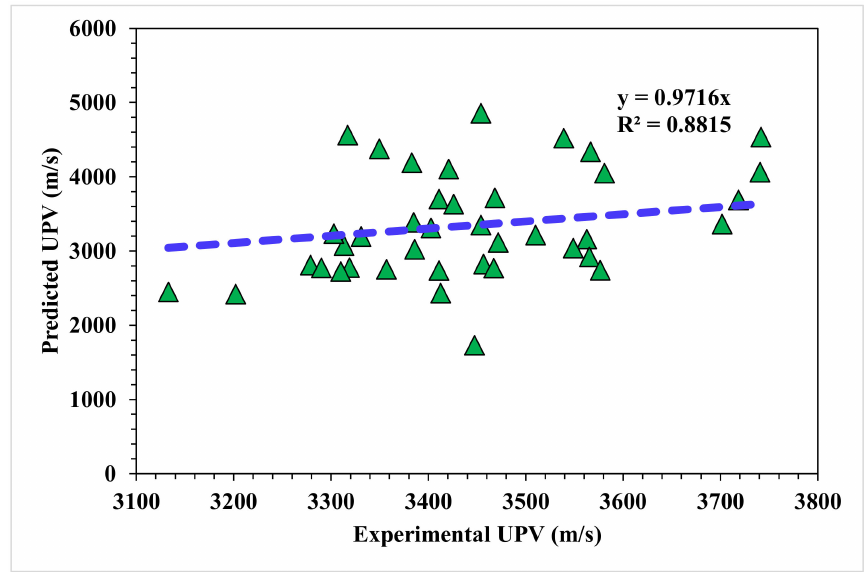
Figure 6. MLPNN model experimental and predicted results.